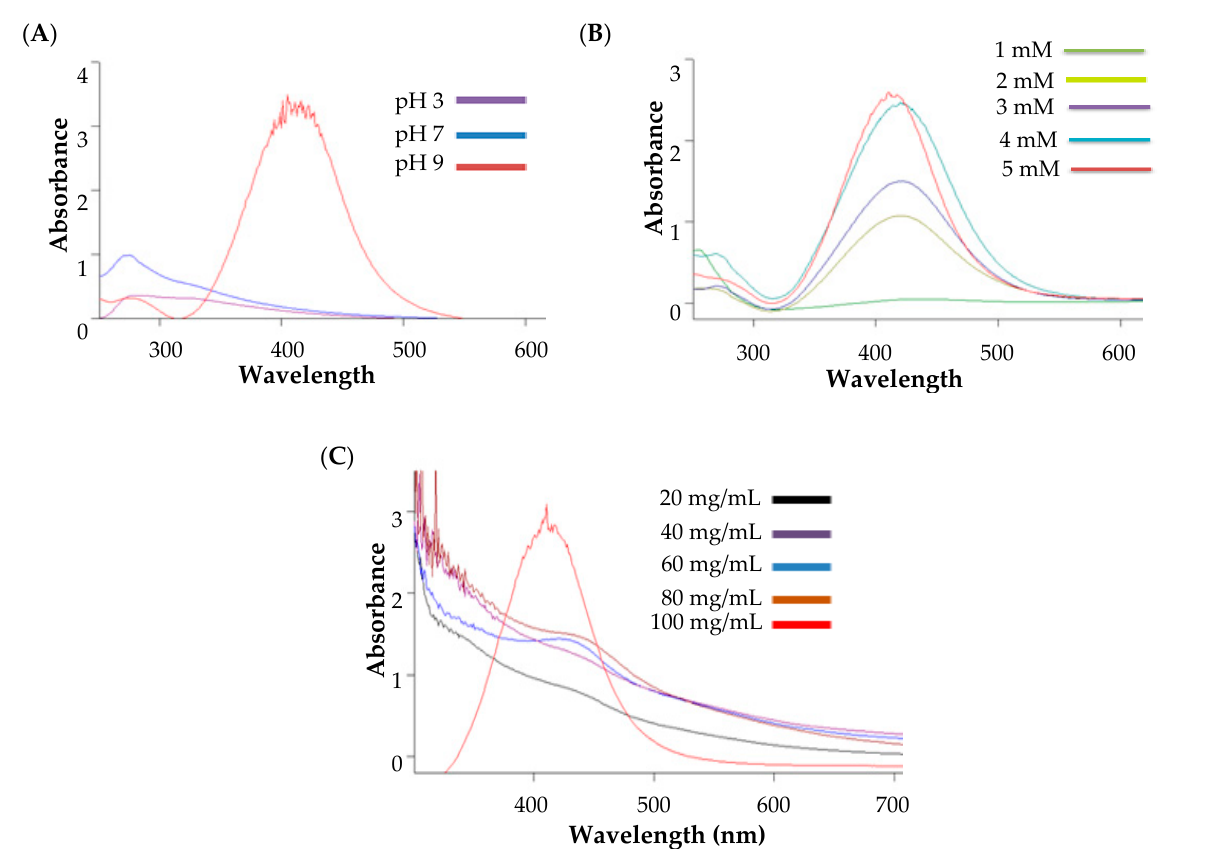
Figure 1. UV–visible spectra showing effect of ( A ) pH; ( B ) silver nitrate concentration; and ( C ) guggul concentration on the synthesis of AgNPs.